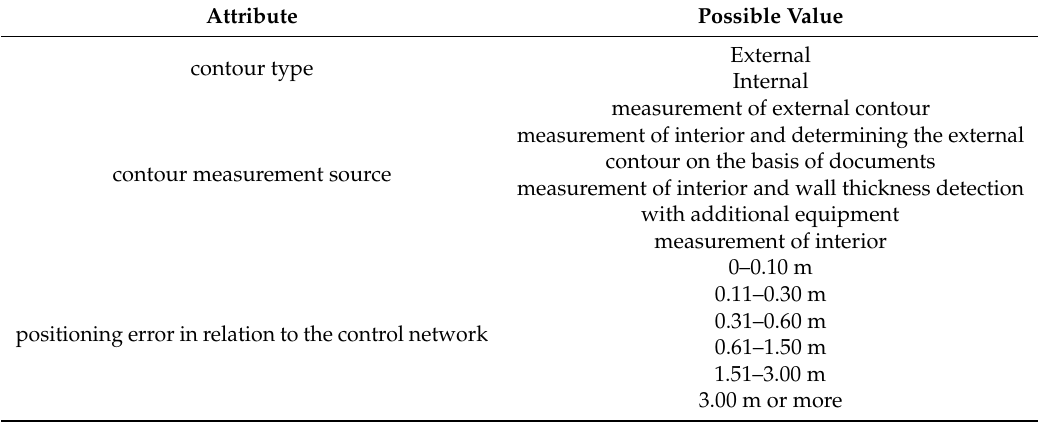
Table 2. Proposal of additional attributes for underground objects.